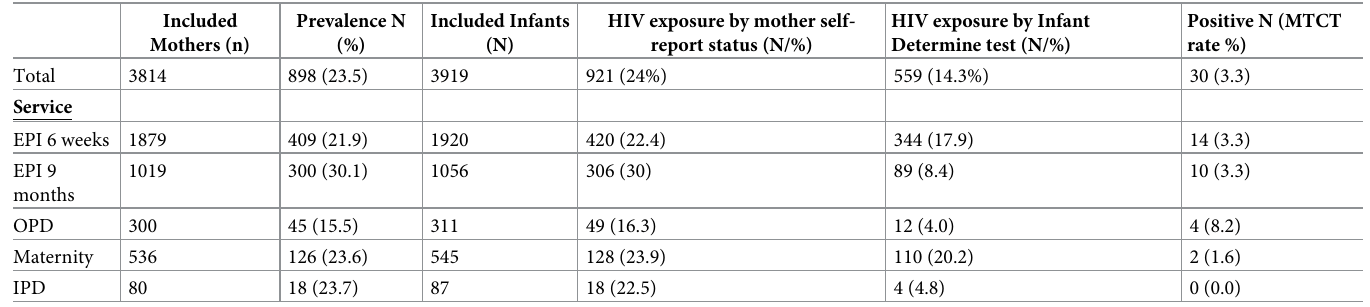
Table 1. Summary of HIV exposed children by